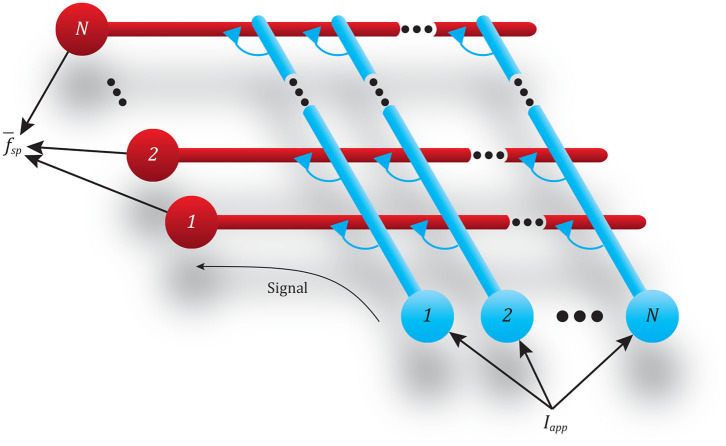
Diagram showing the all-to-all connectivity scheme used between populations of spiking neurons. The N input neurons (blue) all receive the same applied current Iapp, causing spikes that transmit this signal via N2 synapses to the N output neurons (red).